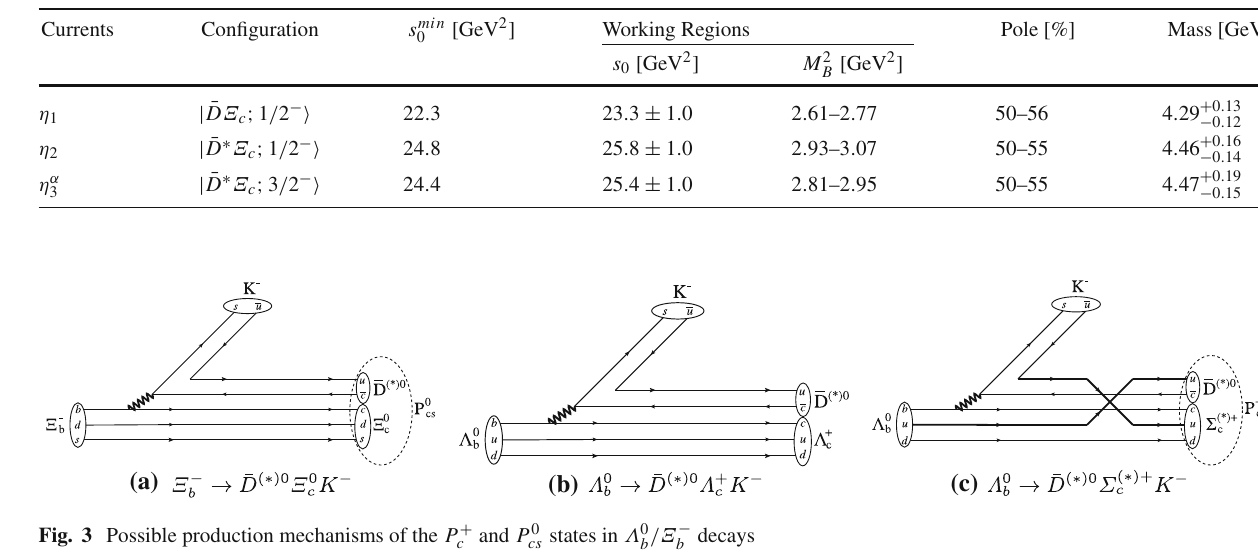
Table 1 Masses of the ¯ D ( ∗ ) Ξ c hadronic molecular states, extracted from the currents η (α)